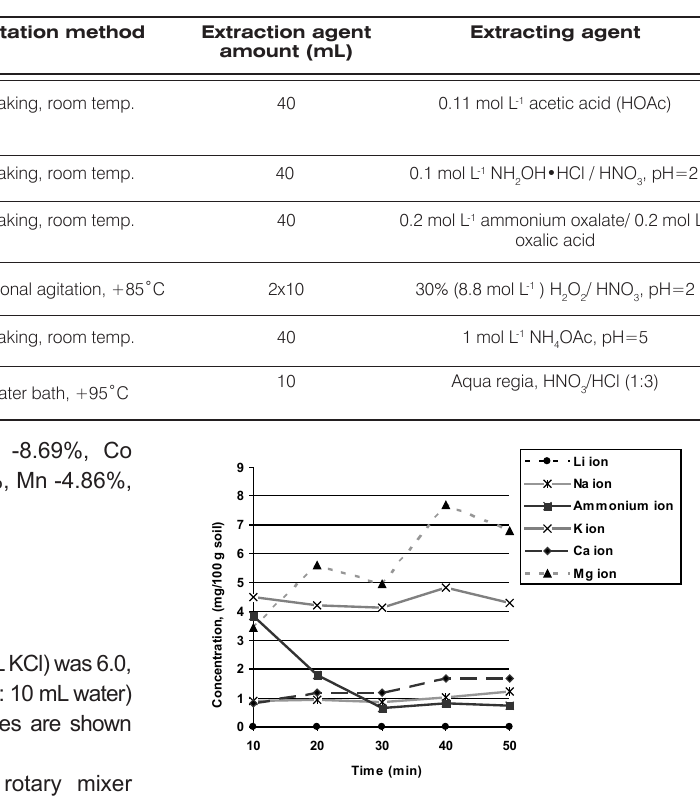
Figure 1. The change of extracted amounts of Li, Na, NH and Mg ions, obtained by means of UAE, with different extraction times (mg/100 g